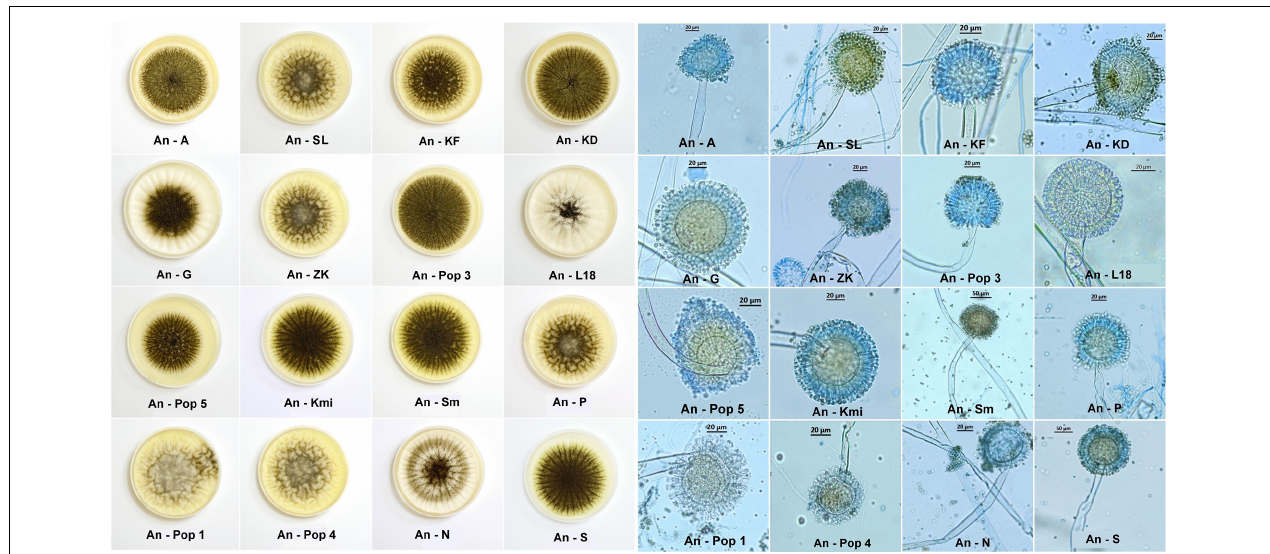
FIGURE 2 | Macromorphological features of Aspergillus niger environmental isolates on the fifth day of cultivation on SDA agar in Petri dishes with a diameter of 6 cm. Colonies form different diameters and also sporulation depending on environmental contamination (left side). Micromorphological features of Aspergillus niger environmental isolates on the fifth day in a drop of lactic acid enriched with cotton blue stain (0.01%). The figures show deformations of conidiophores, such as swelling, narrowing or deformation of the conidial head (vesiculum). We assumed that these deformations can be caused by long term contaminated environment (right